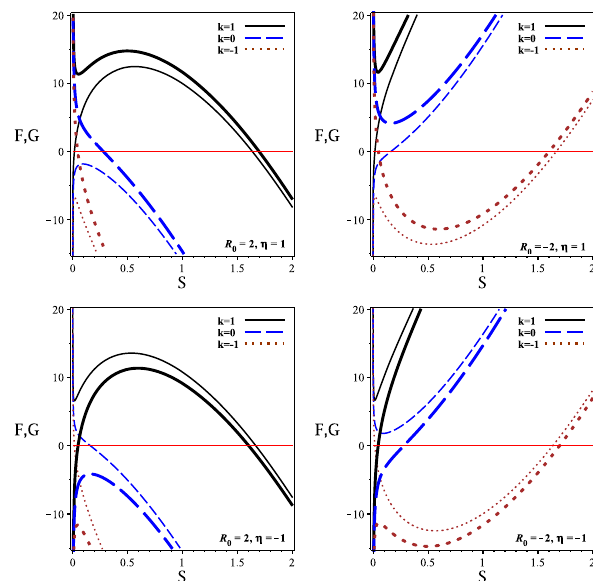
Fig. 5 The Gibbs potential and the Helmholtz free energy versus S for Q = 0 . 02, and f R = 0 . 1. Thin and bold lines are related to G and F ,